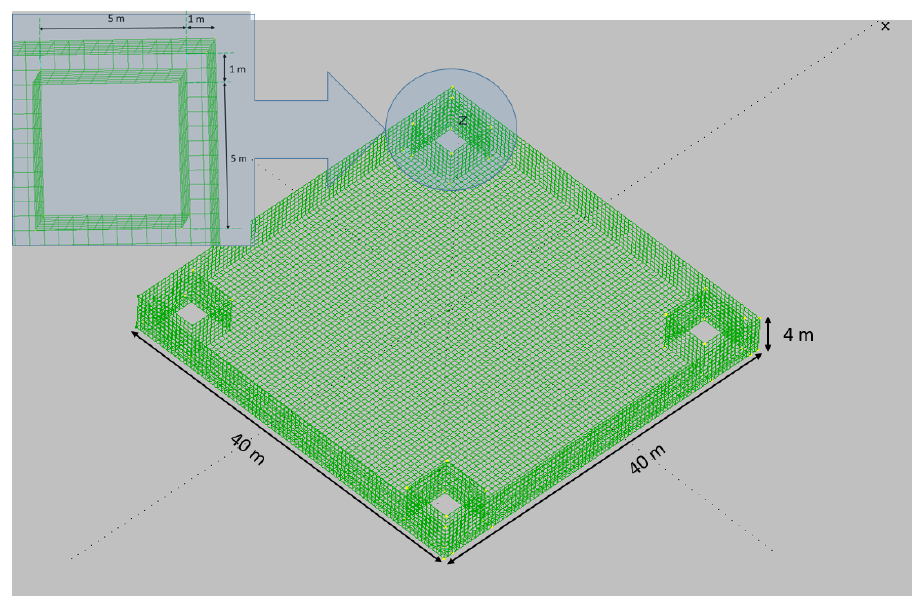
Figure 3. Geometry of the platform with four OWCs. Table 1 details the characteristics of the barge platform and the 4OWC